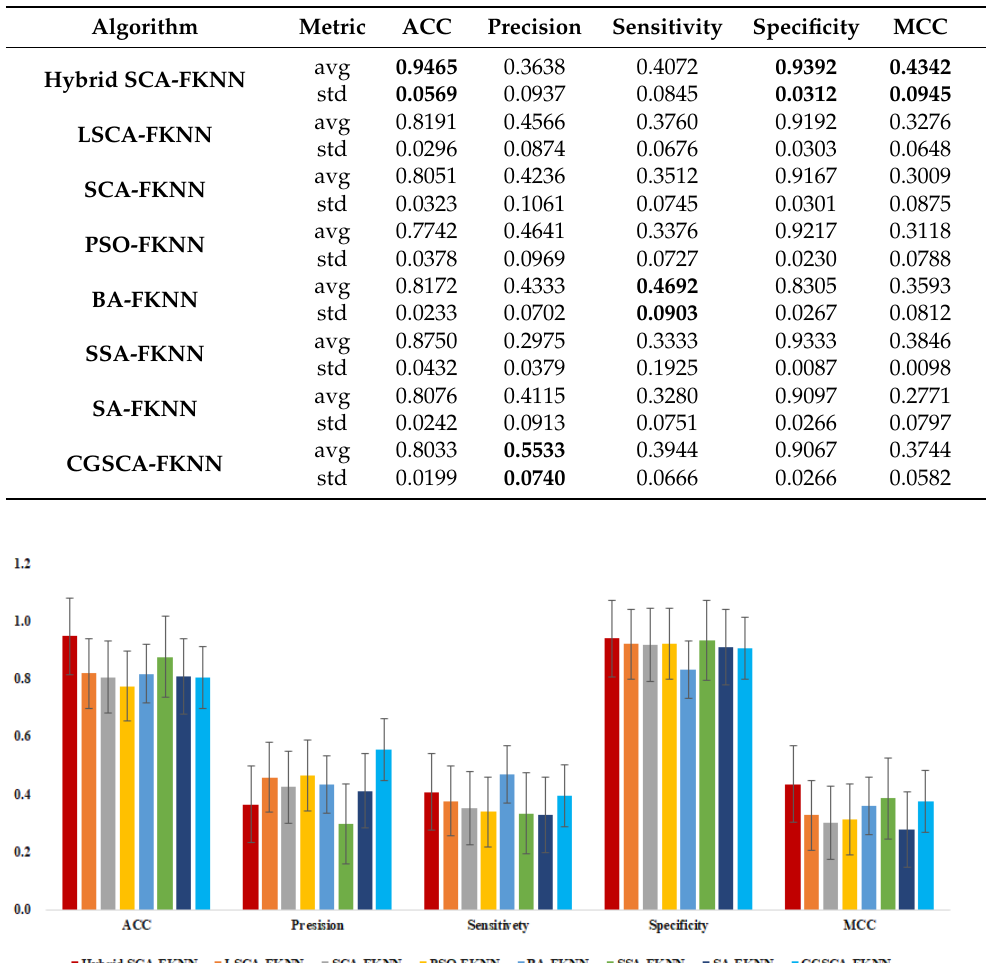
Table 5. Results of the hybrid-FKNN and comparison models on the hepatitis dataset. (Bold indicates the best in comparison method).